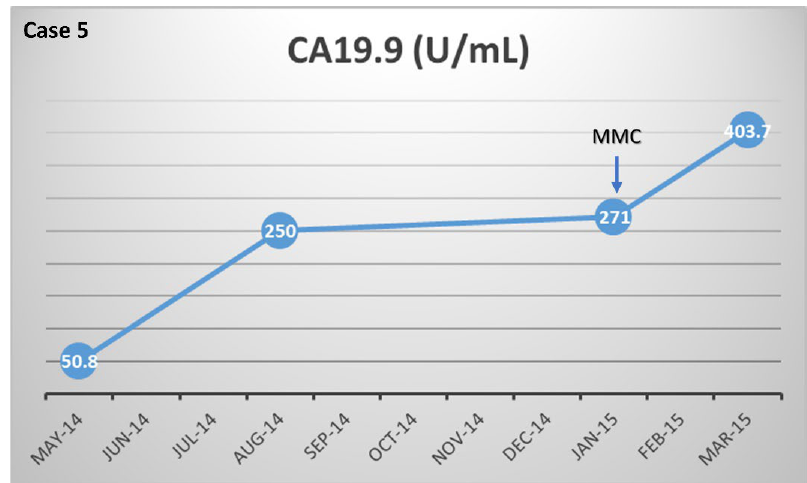
Figure 1. CA 19.9 dynamics on MMC treatment. Legend: Case 1: In two MMC exposures, reduction of CA 19-9 levels was observed. Case 2: MMC exposure resulted in an important decrease of CA 19-9 levels. Case 3: MMC did not resulted in decreased CA 19-9 levels. Case 4: After four cycles of MMC an expressive CA 19-9 decrease was observed. Case 5: Although MMC treatment, CA 19-9 levels raised.